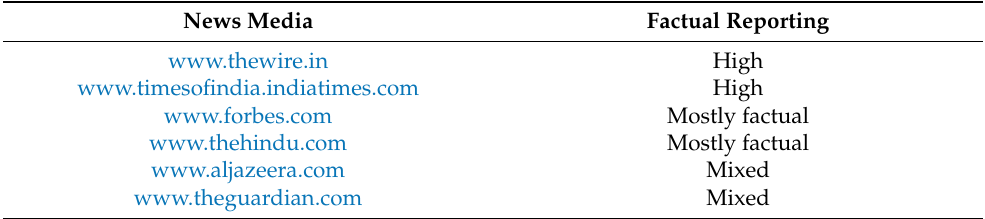
Table 6. Scores of the news